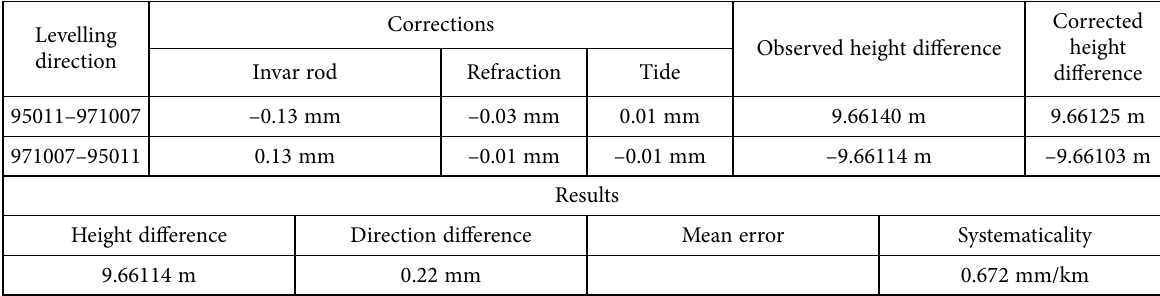
Table 5. Results of the precise levelling